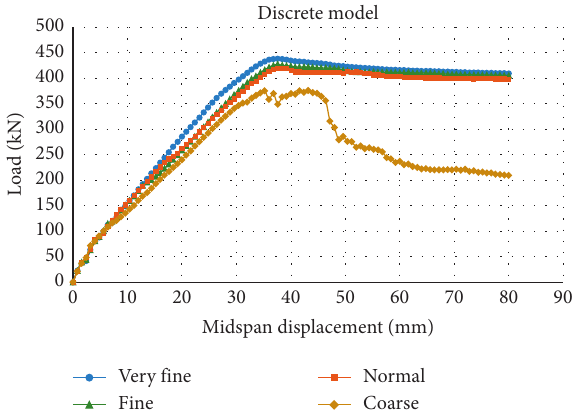
Figure 8: Mesh sensitivity results for the discrete model.